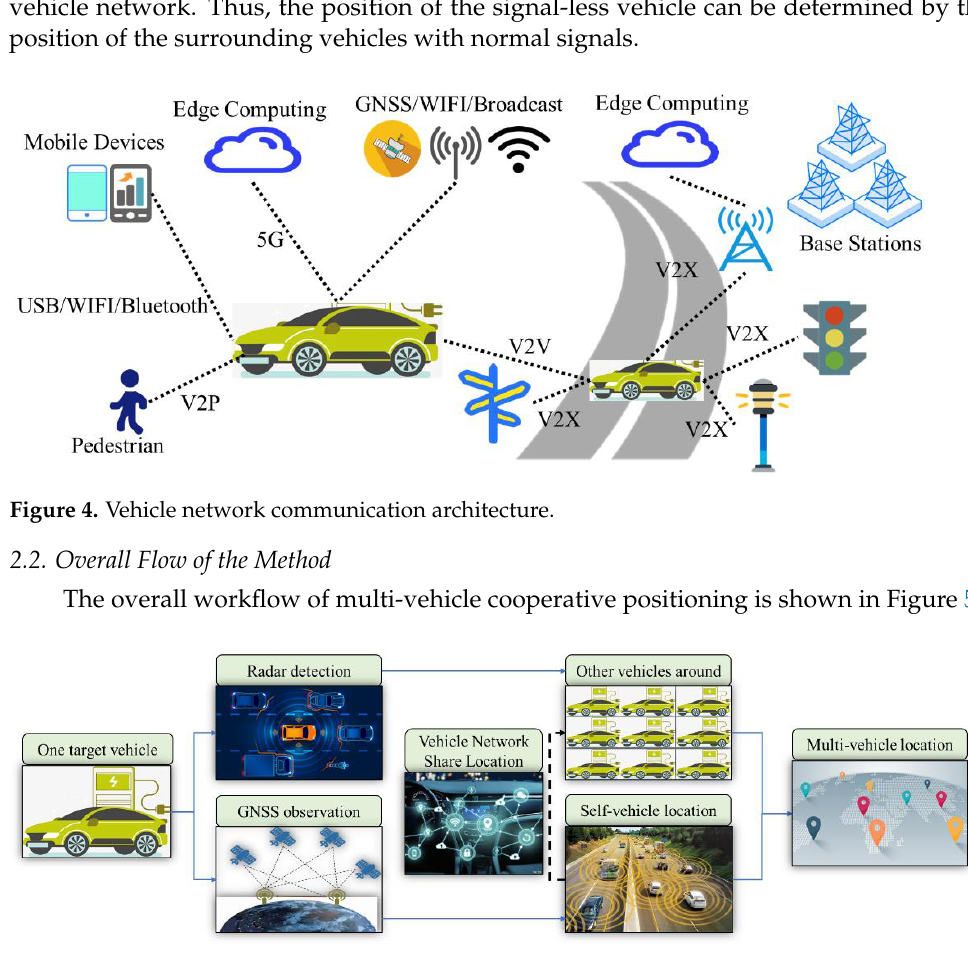
Figure 5. Multi-vehicle cooperative positioning process.